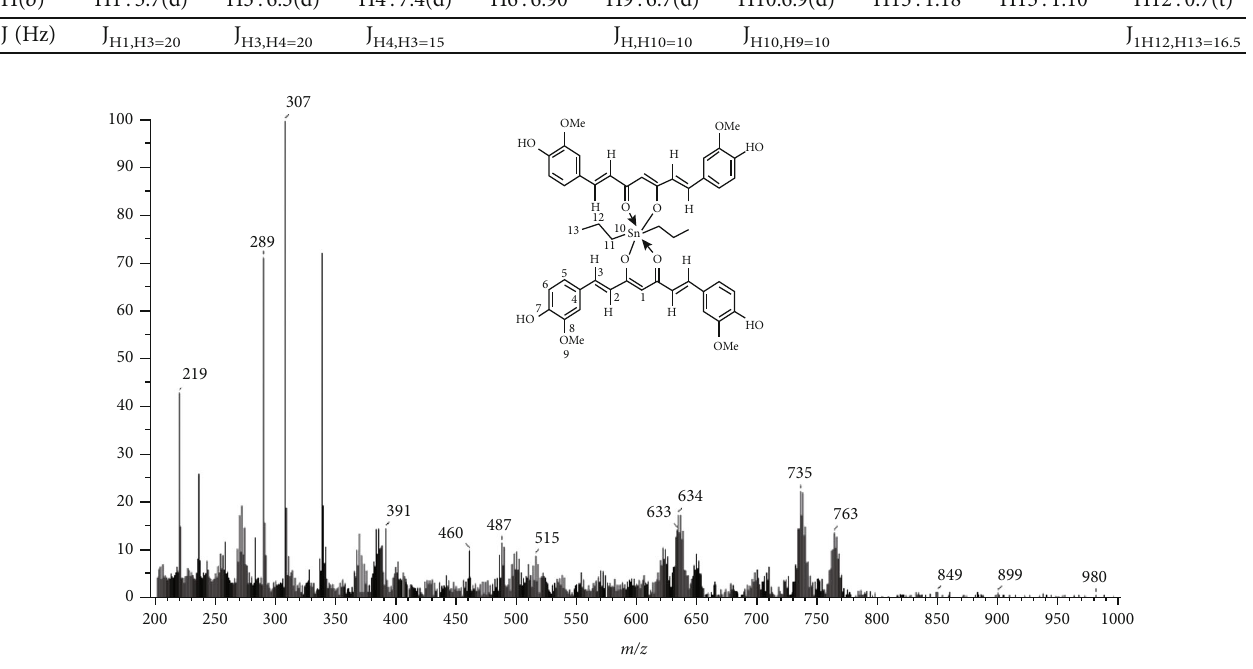
Figure 4: Mass spectrum for the Sn-metallic